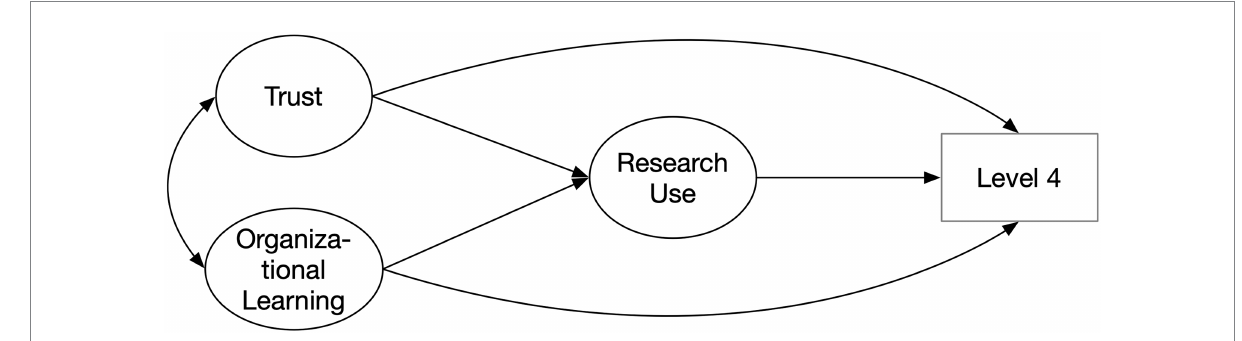
FIGURE 3 Path model on level-1 (1457 school staff members).